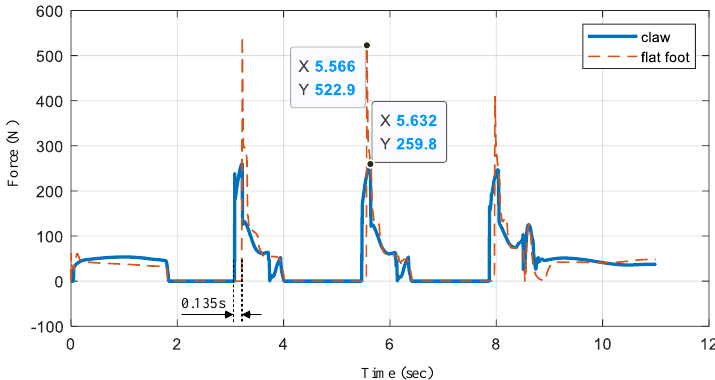
Figure 12. The comparison results of impact with the bionic mechanism.